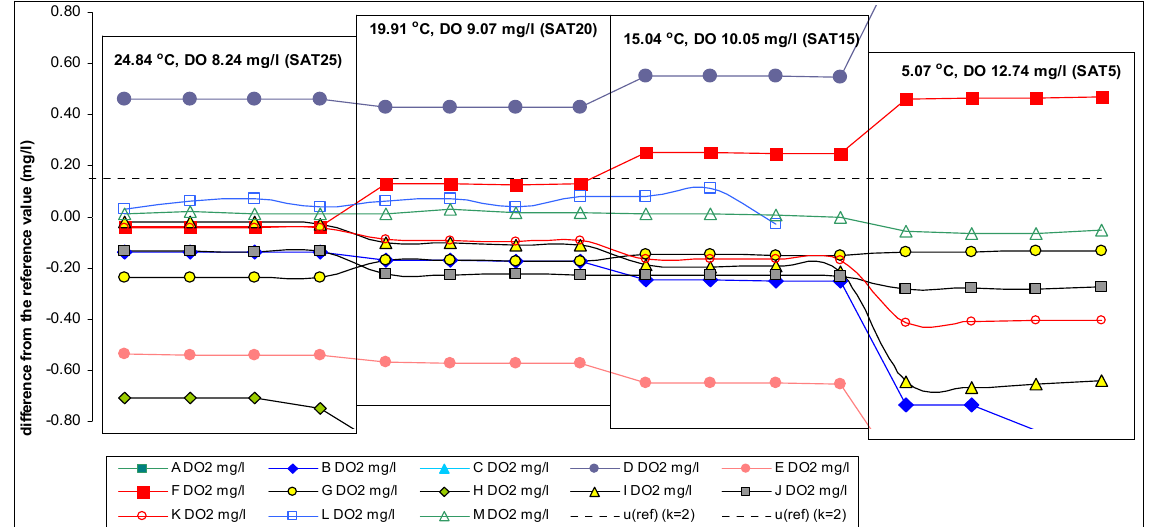
Scheme 4. Differences between DO readings of the participant instruments and the reference values (reduced scale: +0.80 to − 0.80